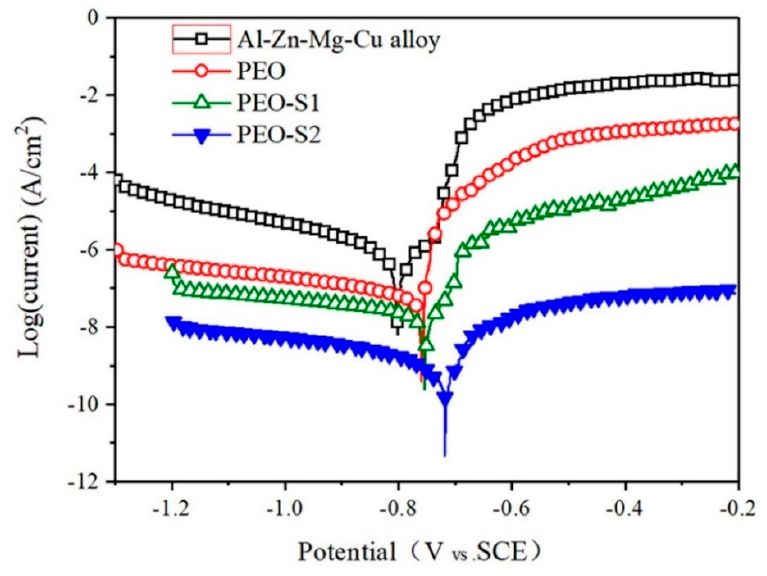
Figure 5. Potentiodynamic polarization curves in a 3.5 wt.% NaCl solution.